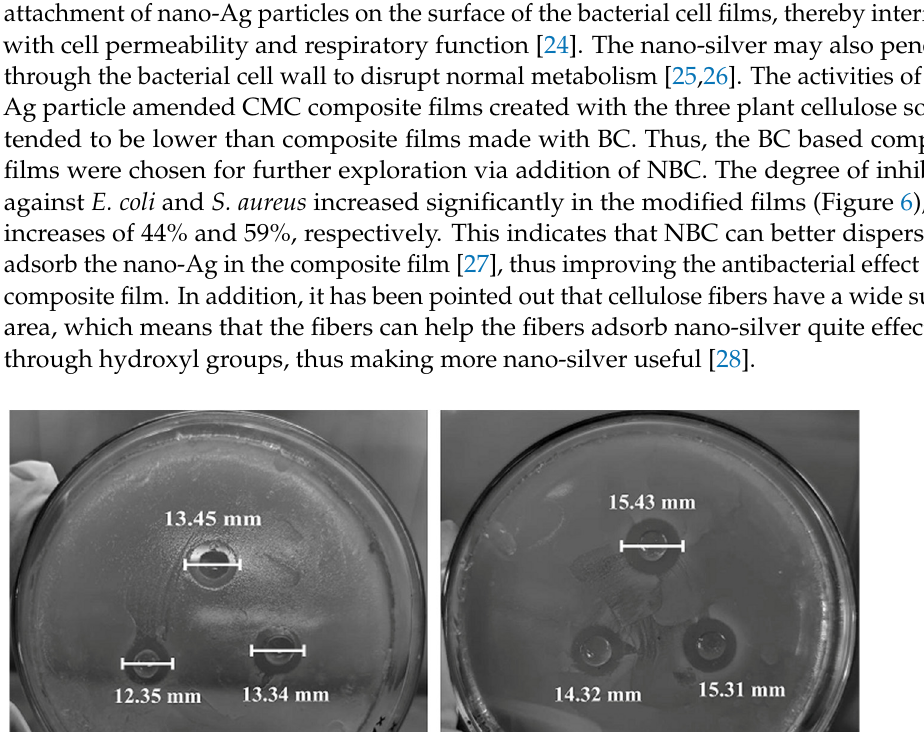
Table 2. TGA thermal values and inhibition diameter of composite film made from bacterial ‐ or plant ‐ derived celluloses *.